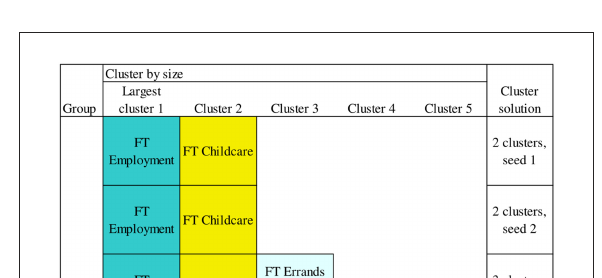
FIGURE2 Time use clusters by size (refugees).